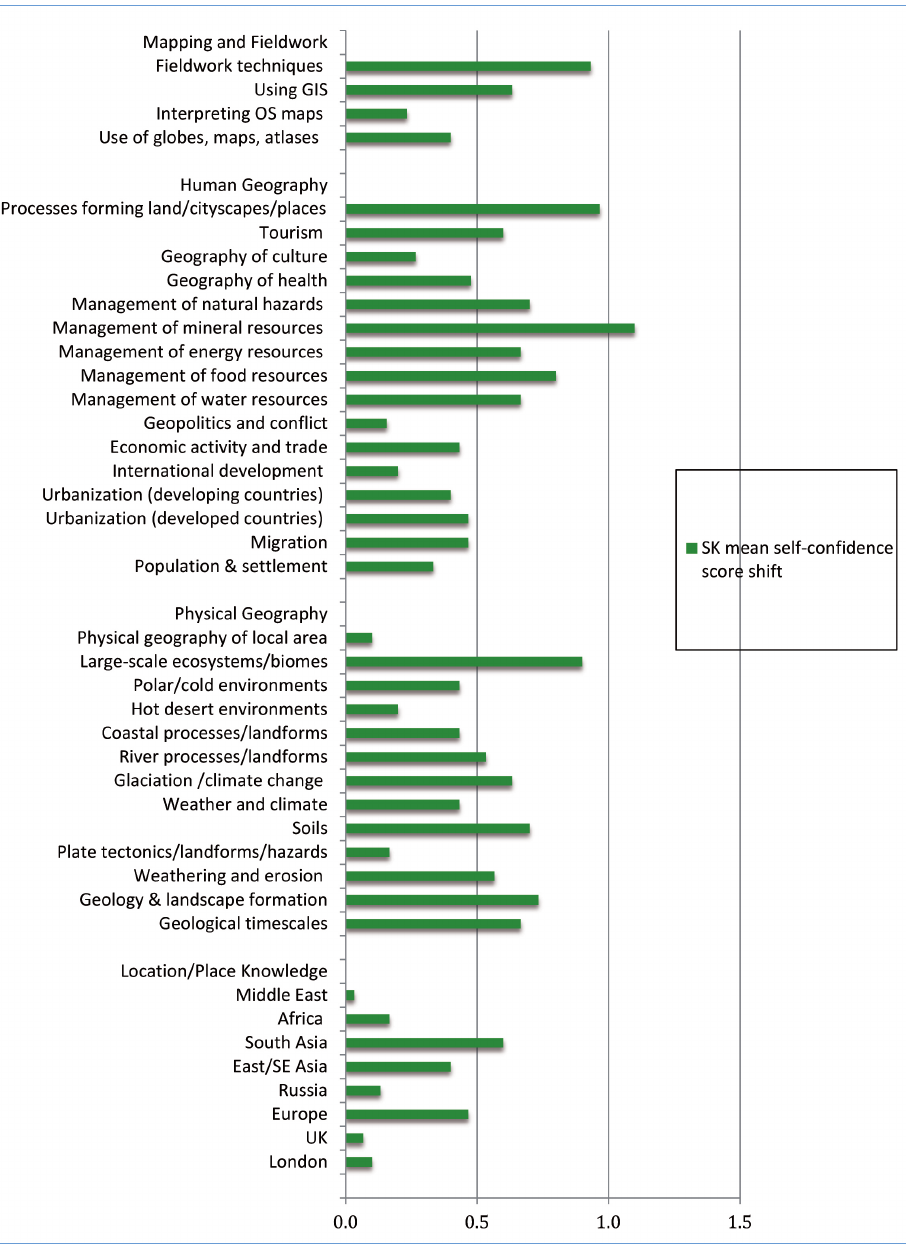
Figure 8: Overallshiftinteacherconfidenceofsubjectknowledge(secondary). Differenceinthemeansecondaryteachers’confidenceself-scorefornationalcurriculumtopics